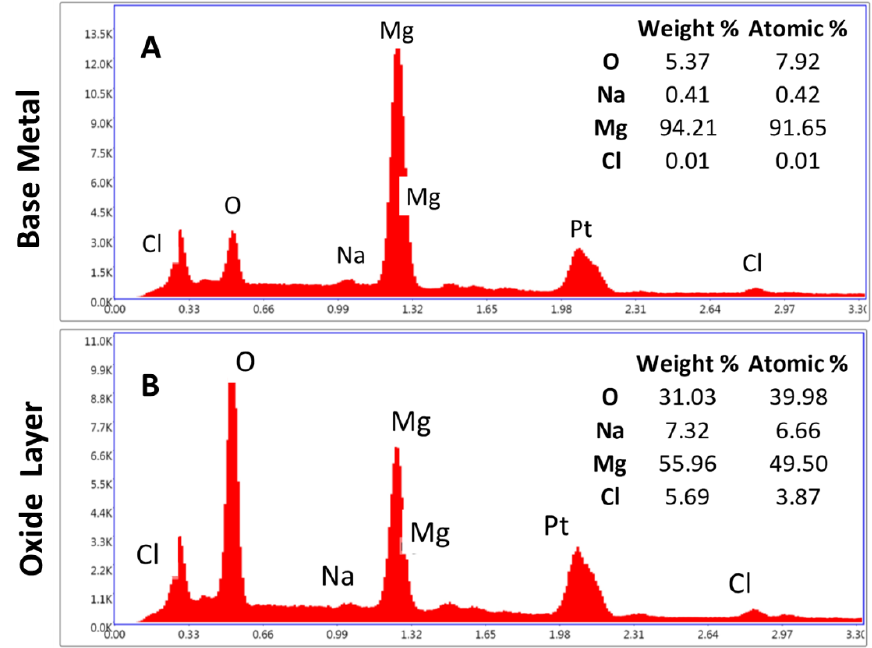
Figure 9. EDS point analysis was performed on the roughened sample’s cross-section. The elements present were averaged. ( A ) EDS results for the base metal and ( B ) EDS results for the oxide layer. The oxygen in ( B ) represents the expected amount for brucite. Other regions had a% of oxygen as approximately half the amount. Sodium and chlorine are present as a result of the salt fog chamber. Platinum is present from the platinum–palladium sputter coating used.